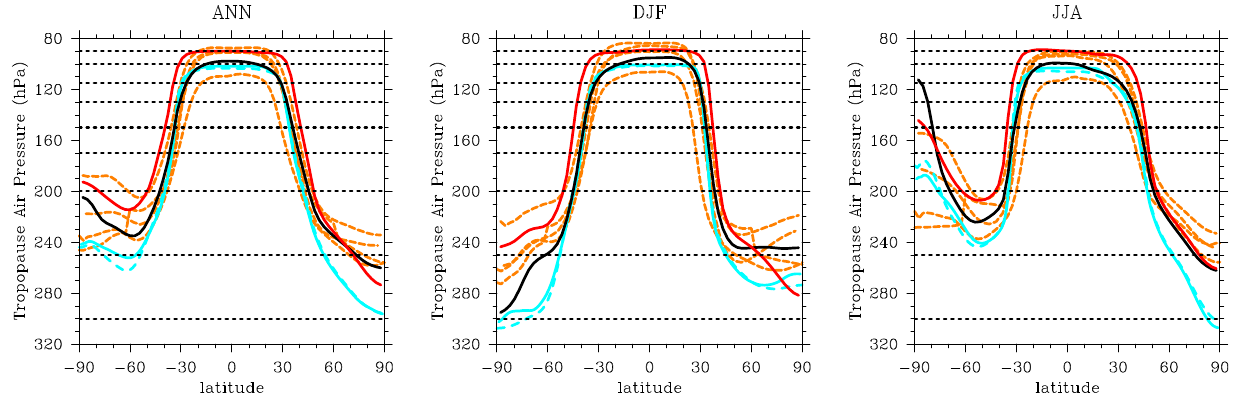
Fig. 8. Climatological zonal tropopause pressure (hPa), annual mean (left column), DJF (middle column) and JJA (right column). 1980–1999 values (except for ERA-Interim) for ERA-40 (cyan line), ERA-Interim (1989–2008, dashed cyan line), CNRM-ACM (red line), CNRM-CCM (black line) and CCMVal-2 REB-B1 models (dashed orange lines). Dotted horizontal lines represent the CCMVal-2 vertical model resolution around the tropopause.